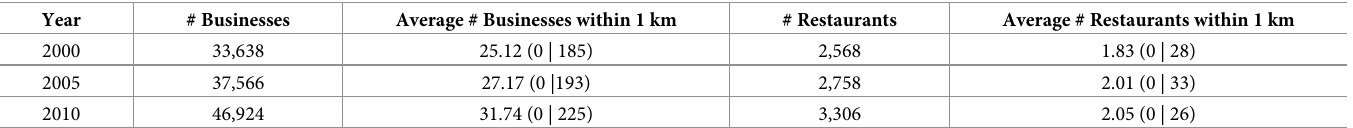
Table 1. The number of registered businesses and restaurants for each year is presented along with the average number of businesses and restaurants within the 1 km buffer of each point count. Minimum and maximum of # of businesses and restaurants within 1 km buffer are presented in parenthesis (min | max).